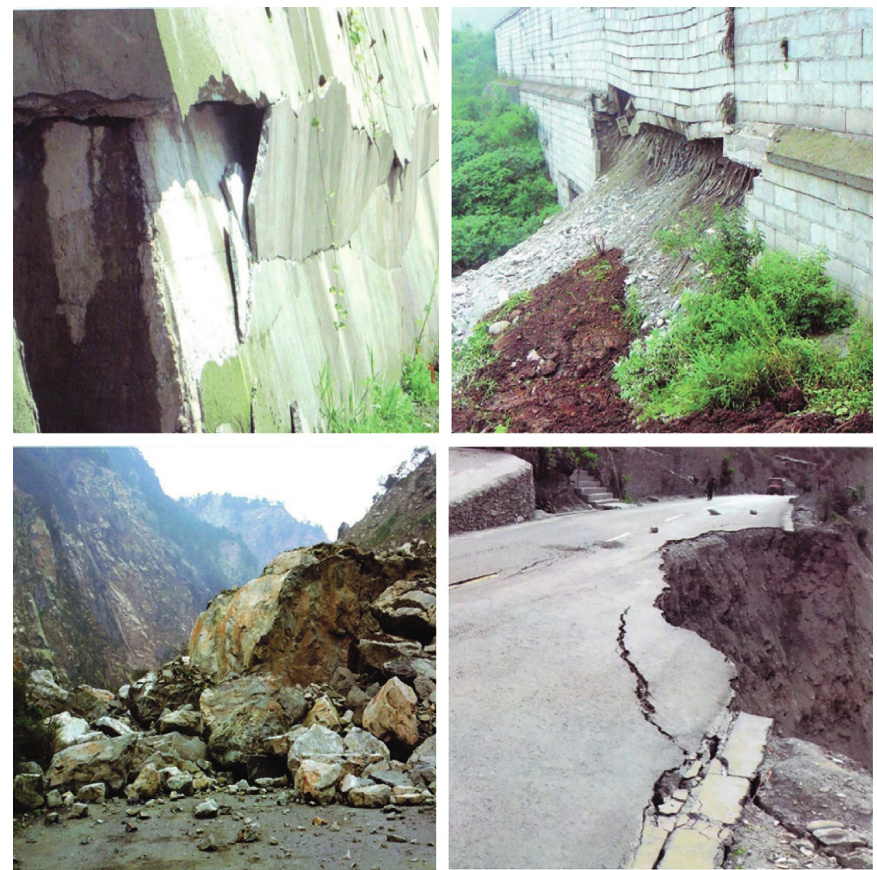
Figure 1: The typical damage of the road in the Wenchuan earthquake, including the retaining wall being cut, the wall body being inclined outward, the subgrade being buried by the rock, and the subgrade partially collapsed [23].